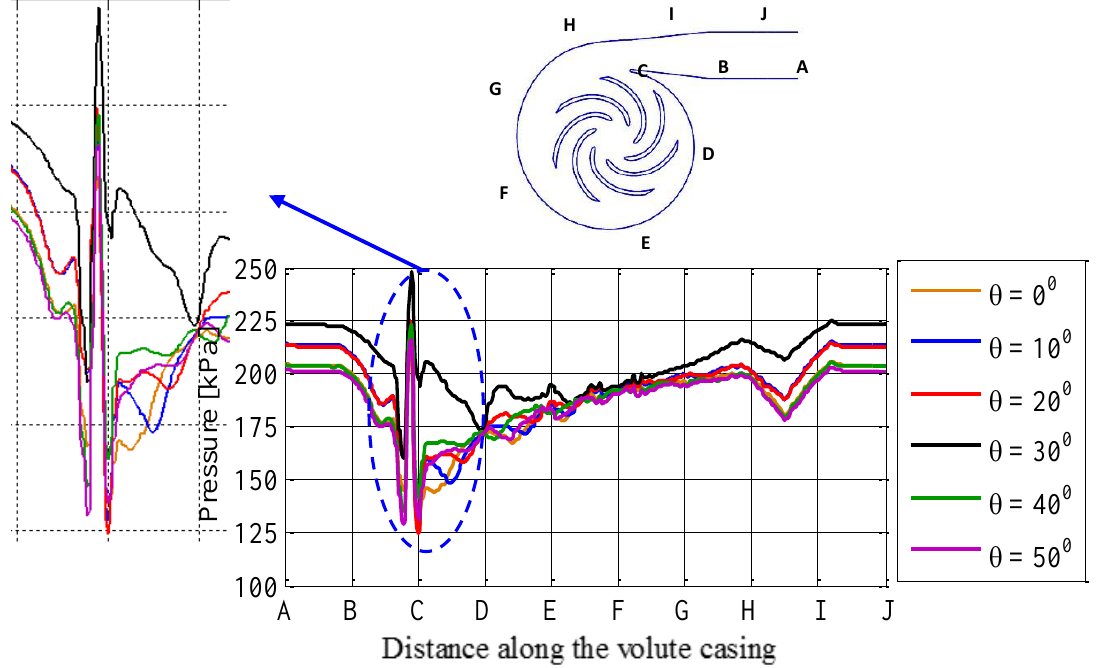
Figure 15. Variation of the pressure along with the casing of the centrifugal pump at different phases of rotation.